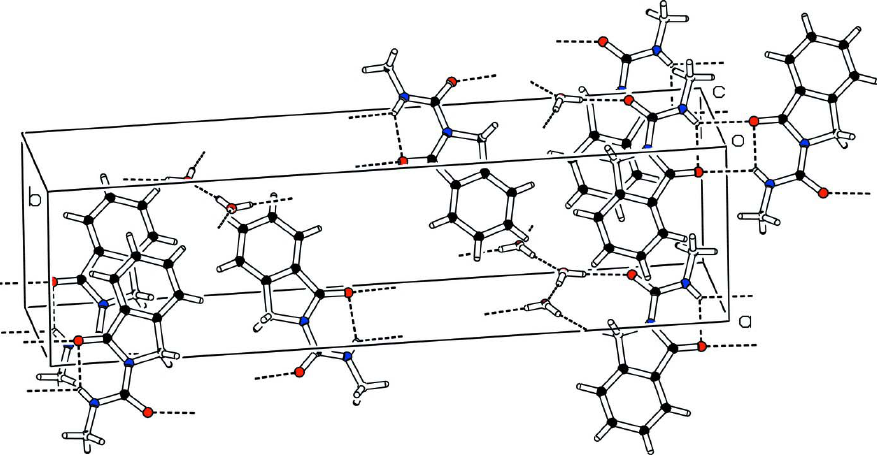
The ORTEP diagram of the title compound (I) with displacement ellipsoids at 50% probability level; intramolecular interaction has been indicated by broken line. H-atoms are shown by small circles of arbitrary radii.